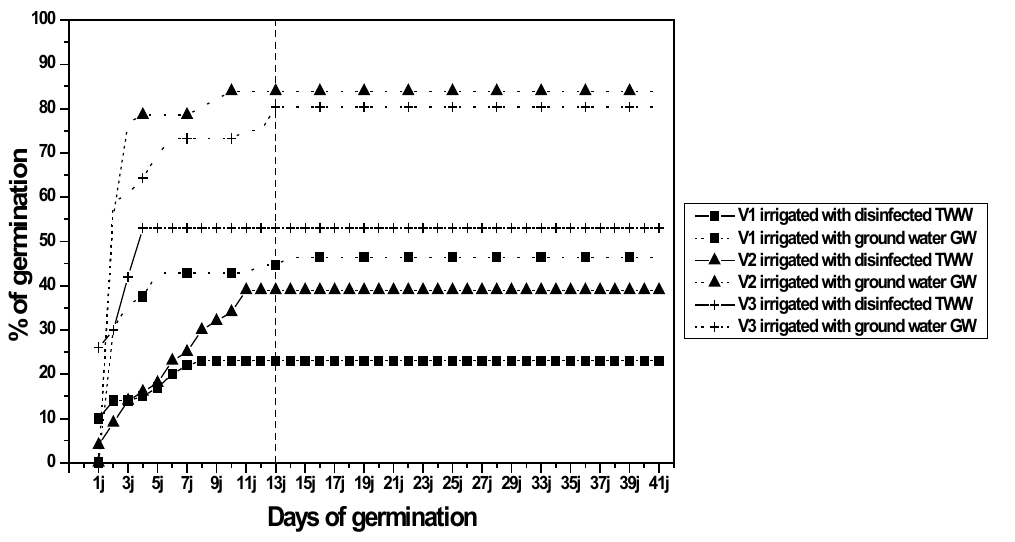
Figure 3. Evolution of the germination percentage of the different seed varieties irrigated with the two kinds of water: well water and disinfected treated wastewater.